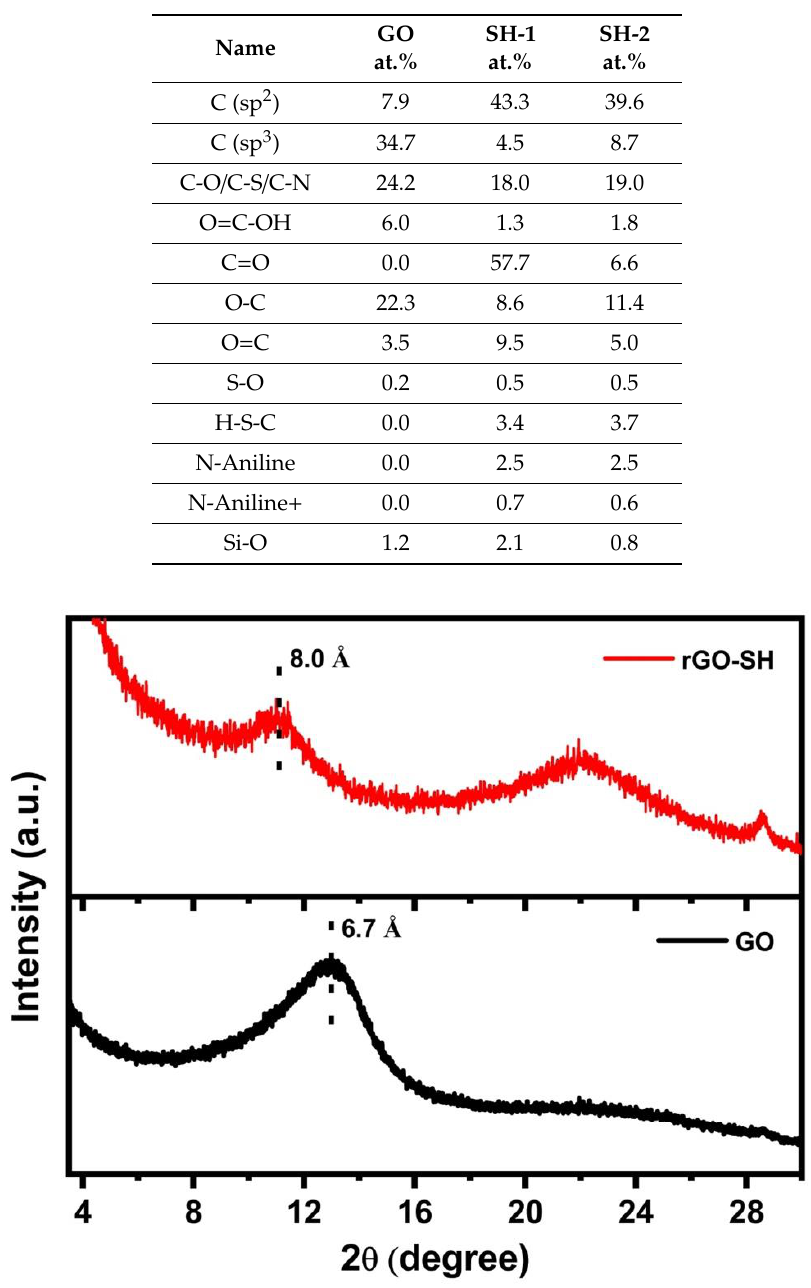
Table 1. Surface composition of the GO, rGO–SH-1 (SH-1), and rGO–SH-2 (SH-2) samples according to the core level spectra analysis.